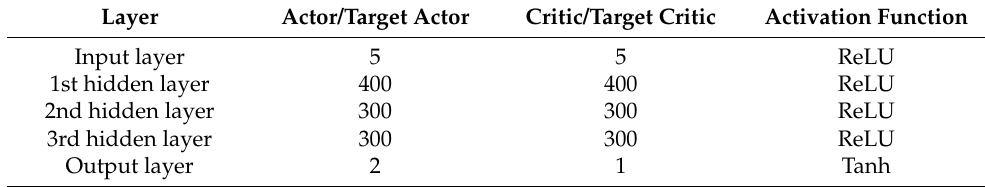
Table 1. Hyperparameters of networks.